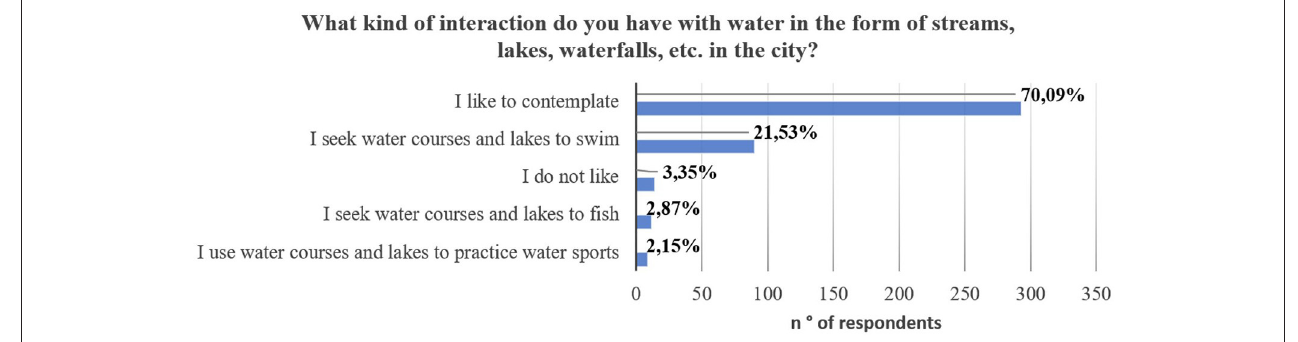
FIGURE 13 | Most common uses for the rivers of Lavras. Source: Sousa R. B. et al.